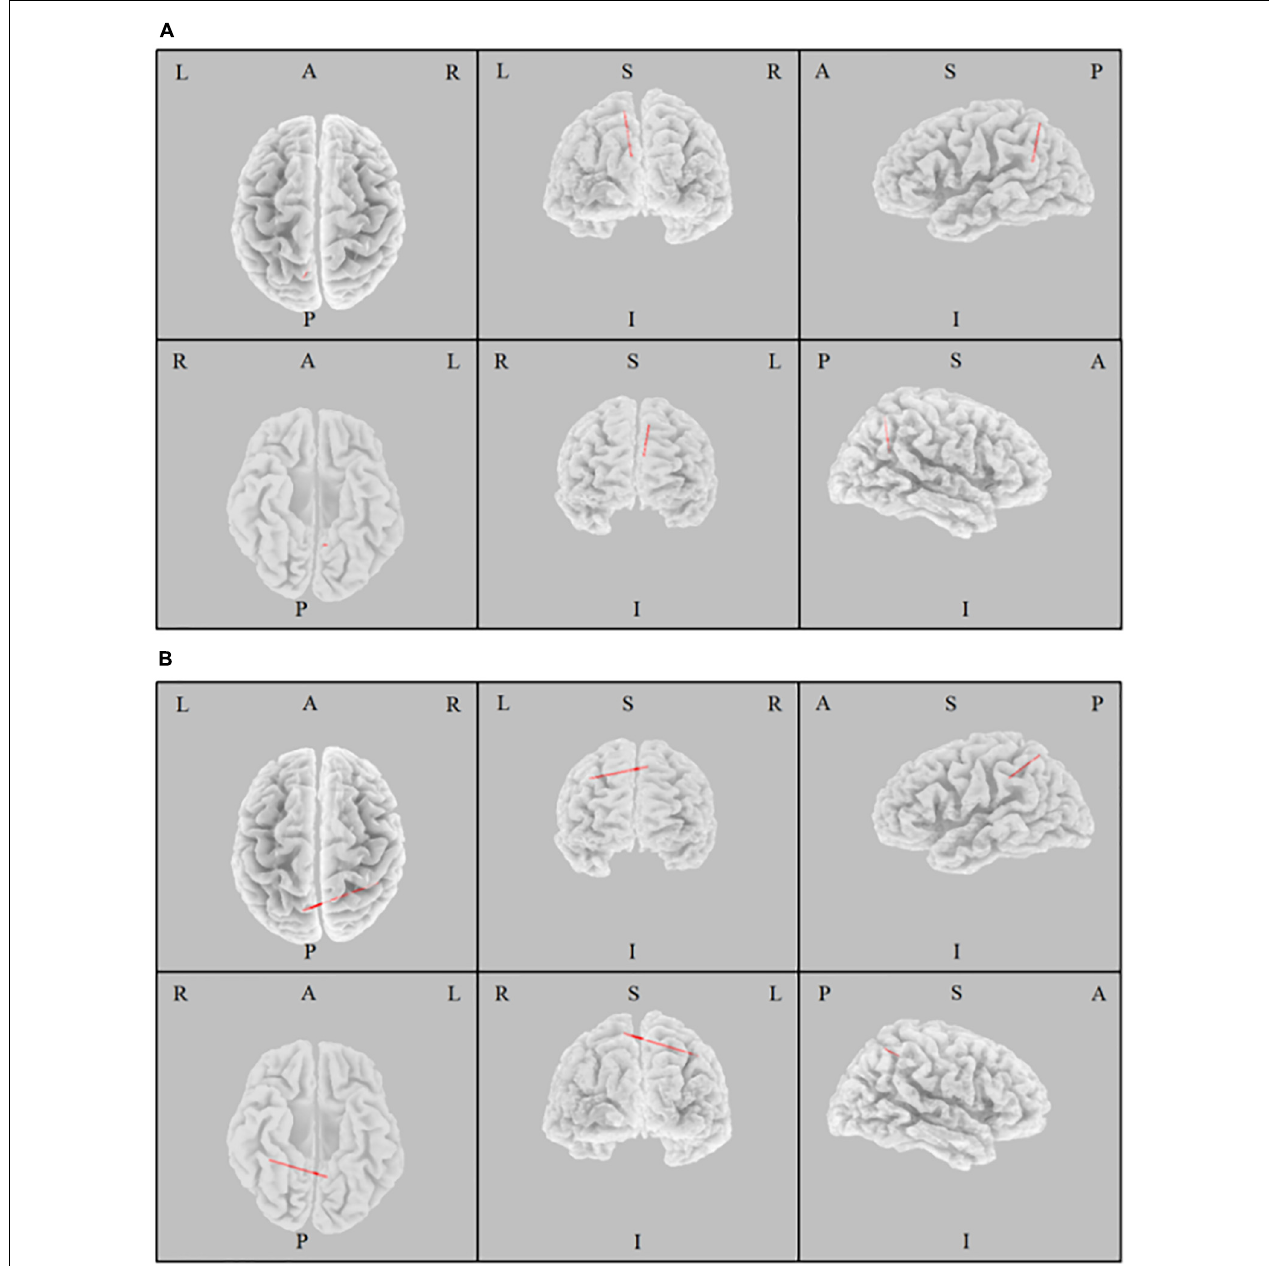
FIGURE 2 | The Change of Effective Connectivity between eyes open and eyes closed states. The effective connectivity from the left precuneus to the left posterior cingulate cortex (A) and to the right inferior parietal lobule (B) of beta band was significantly increased in the eyes open state compared with the eyes closed